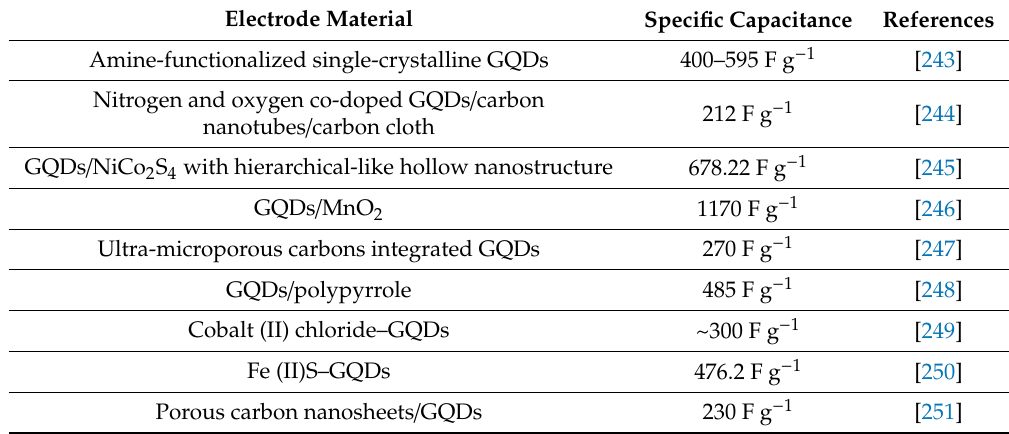
Figure 13. Synthesis of GQDs / HNTs hybrid for the fabrication of micro-supercapacitor electrode [241]. Table 3. Examples of MSCs involving the use of GQDs with their respective capacitive performance.